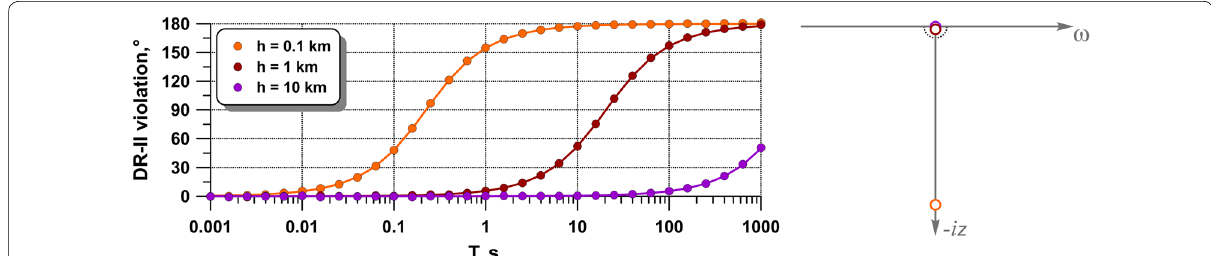
Fig. 3 The DR-II violation in Z yy (dotted line), the best-fit elementary phase lag θ 1 (solid line) and the corresponding lower half-plane zero (open circle) of Z yy (Ω) for various values of